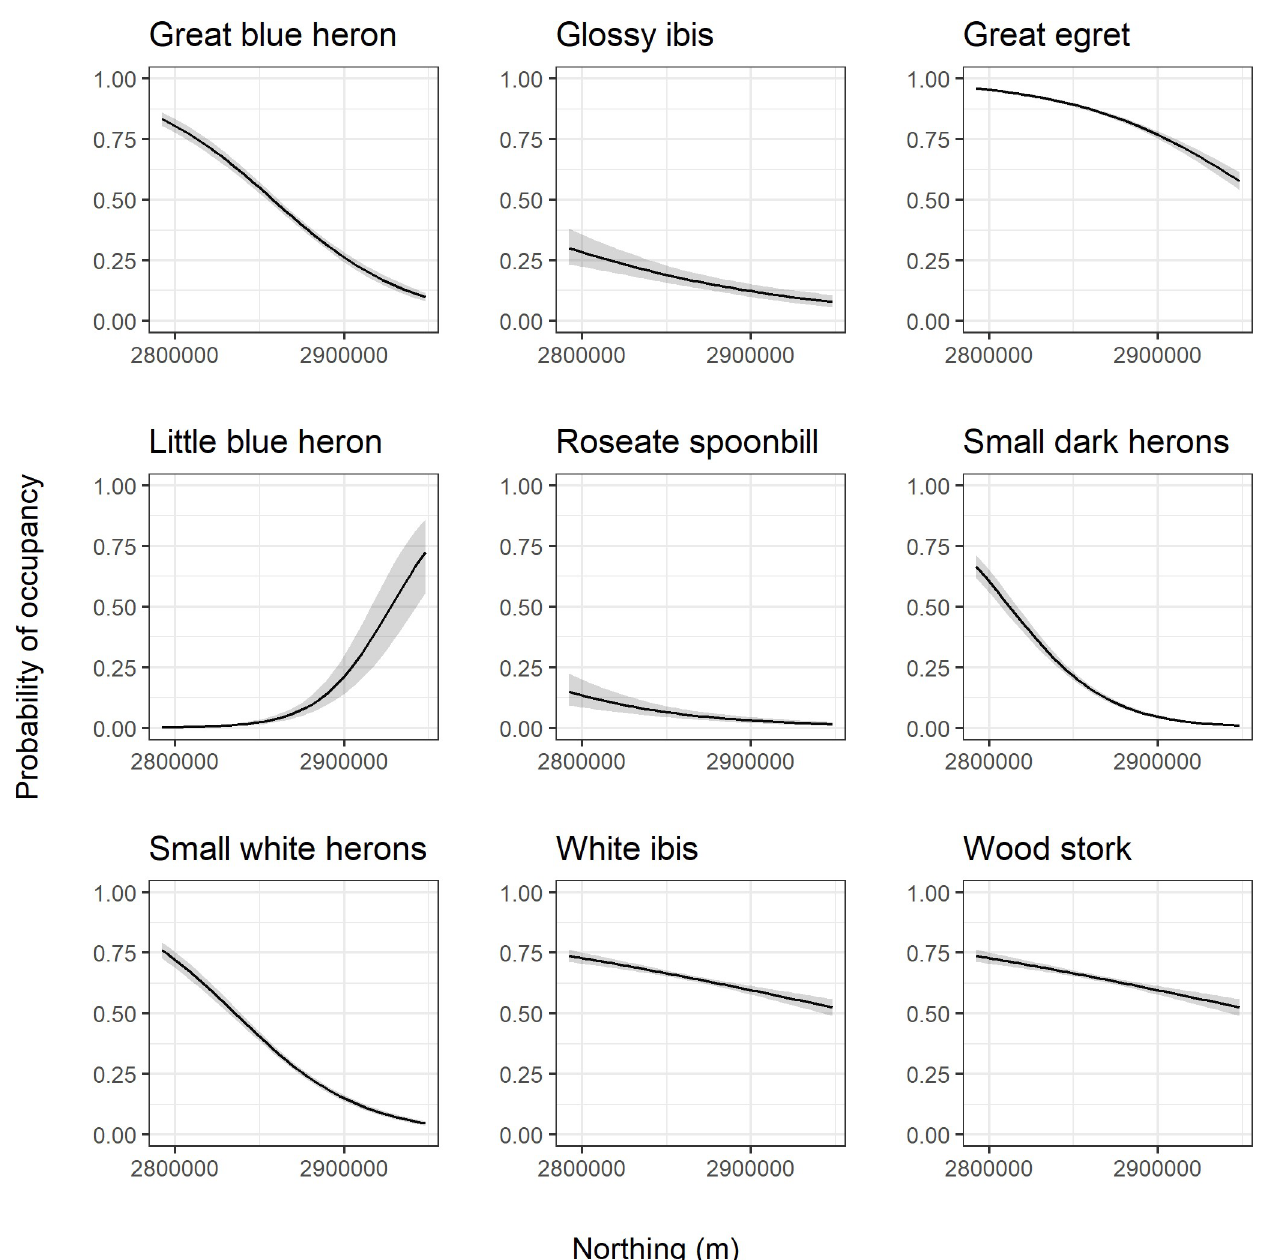
Fig 10. Northing coordinate response curves. Species-specific relationships between probability of occupancy and the northing coordinate from a fitted joint species distribution model of wading birds. Responses are calculated with all other model variables held at their mean. The black line represents the posterior mean and the gray shading represents the 95% posterior